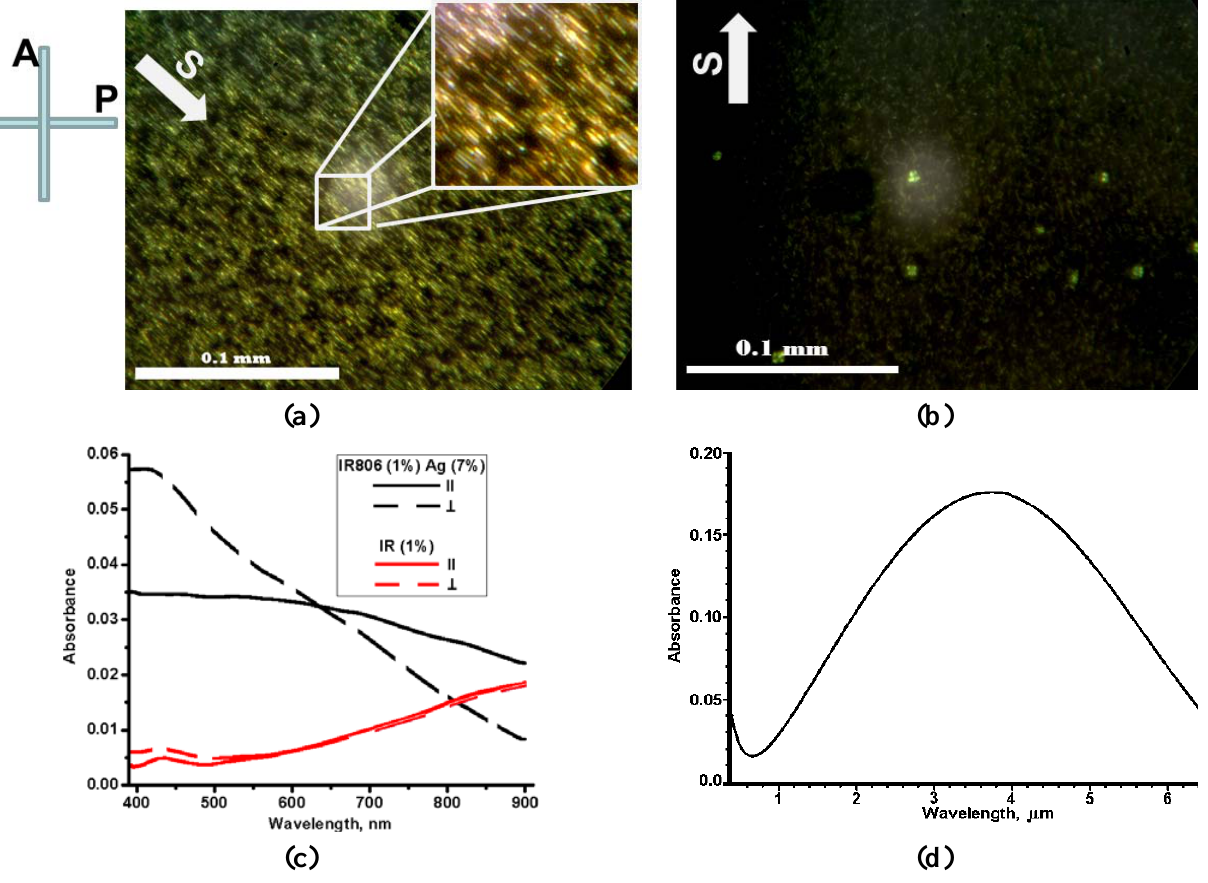
Figure 2. (Color online) ( a ) and ( b ) Textures of Sample No. 2 (dried silver nano-fibers with the infrared dye IR-806) placed between crossed polarizer P and analyzer A, with two different orientations of shearing direction S with respect to P and A; ( c ) Absorption spectra of Sample No. 2 (black line) and same for reference film of dried infrared dye IR-806 (red line) measured with visible and near-infrared lights linearly polarized along ( ∥ ) and orthogonally ( ⊥ ) to the shearing direction S; ( d ) Infrared absorption spectrum of the longitudinal plasmon calculated for the silver nano-fibers NGAP NF